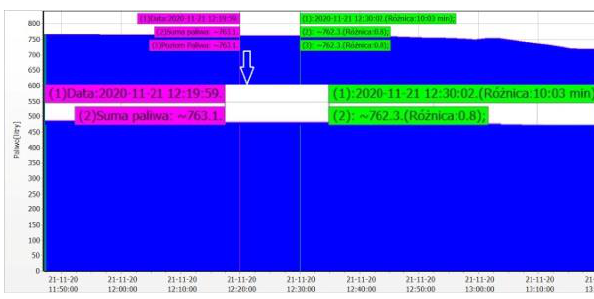
Fig. 10. Measurement of hourly fuel consumption FC [l/h] of a CAT C27 engine (6Dg locomotives) with additive. 1800 rpm. Test F, point 